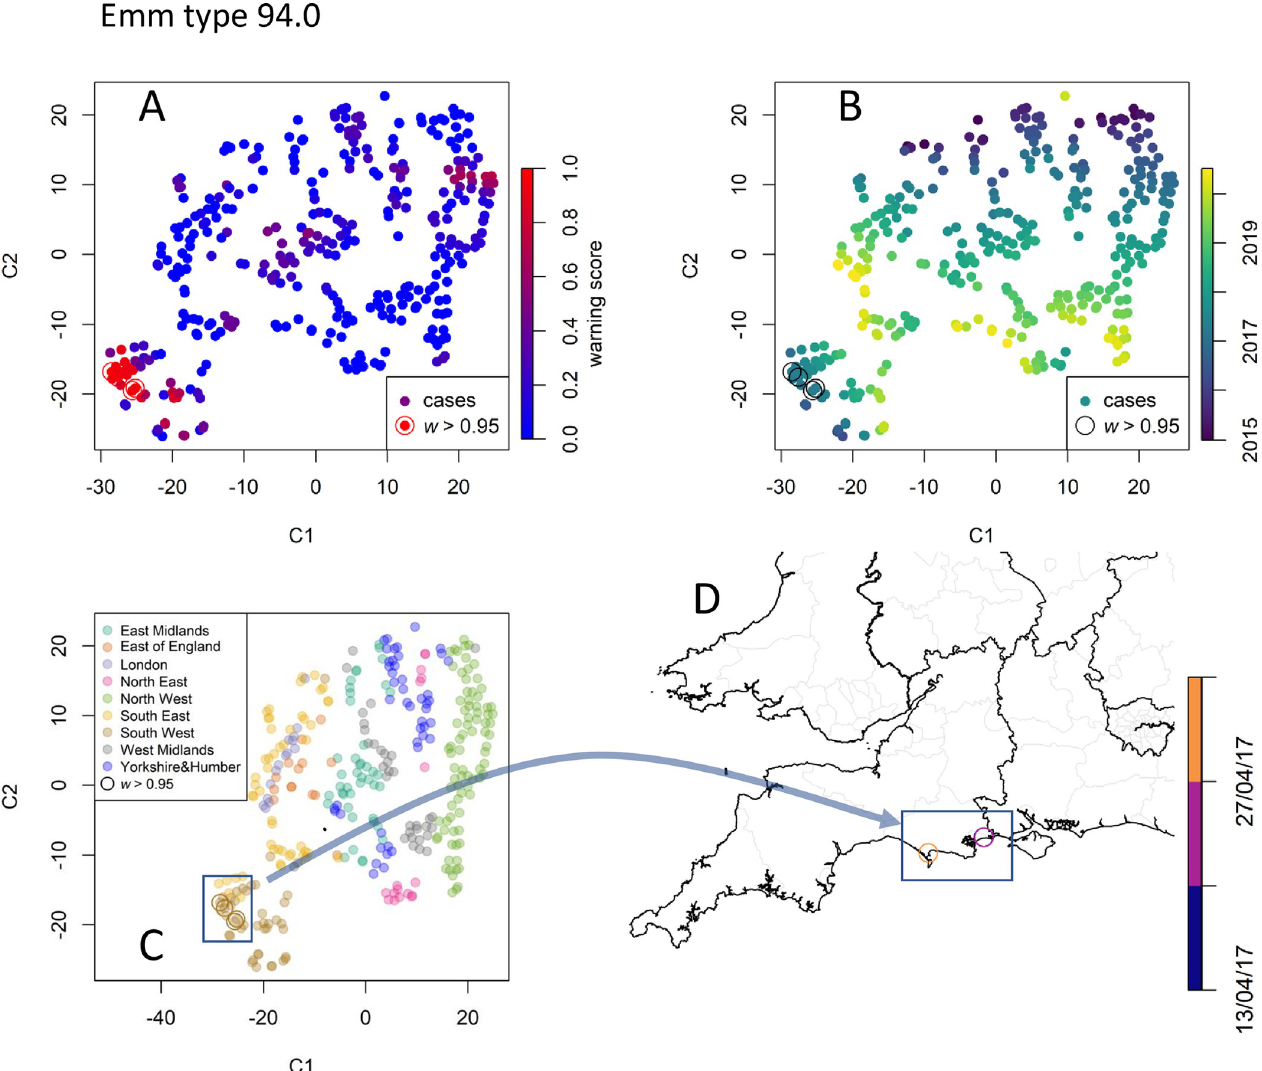
Fig 7. Data point embedding and cluster analysis for emm type 94.0. A Each iGAS record, identified by its position in time and space, is embedded in a two- dimensional space of coordinates C 1 and C 2 according to the t-SNE method. The points are coloured by their warning scores (0 to 1, blue to red), thus showing the presence of a bright red cluster of points with high warning scores ( w > 0.95). Colouring the detected cases by their record time ( B ) and region ( C ) shows that t-SNE preserves the neighbourhoods. D The framed cluster corresponds to cases localised in the towns of Bournemouth and Weymouth. Map created with Sf [55] using shapefiles from the GADM database (https://gadm.org/maps/GBR_1.html) and the Ordnance Survey Data Hub (https://osdatahub.os.uk/